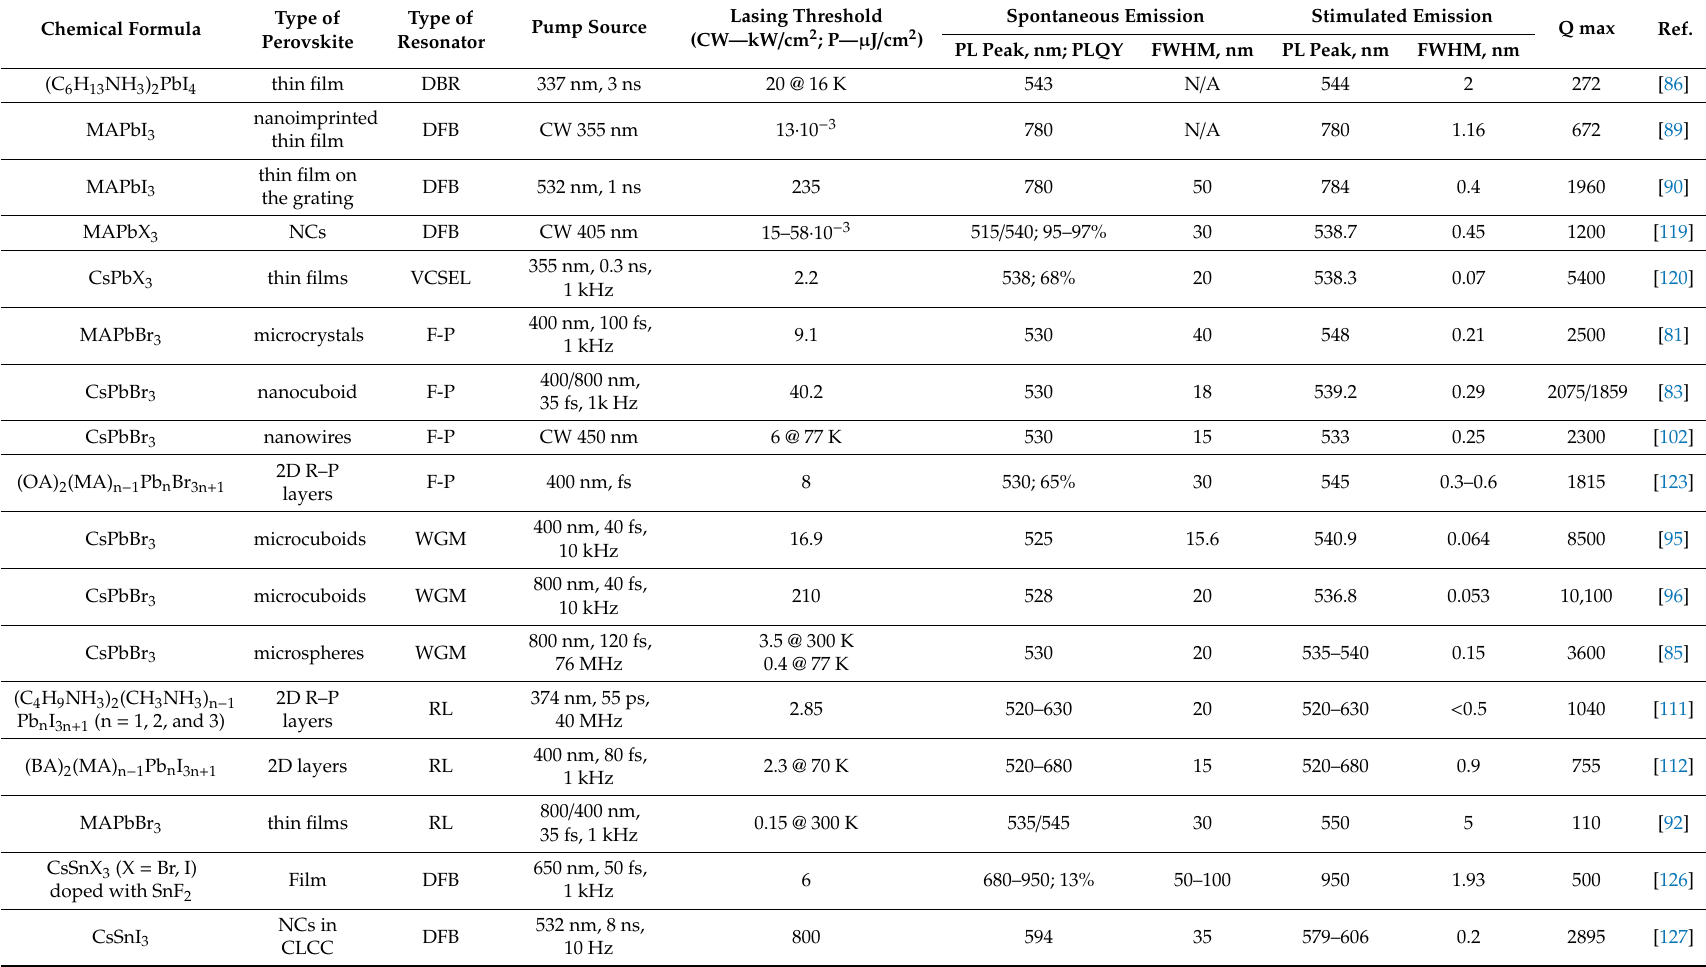
Table 2. Lasing parameters (type of resonator, pump source, lasing threshold, Q) vs. type of perovskite material (chemical formula, morphology, emission parameters) for the samples with the best